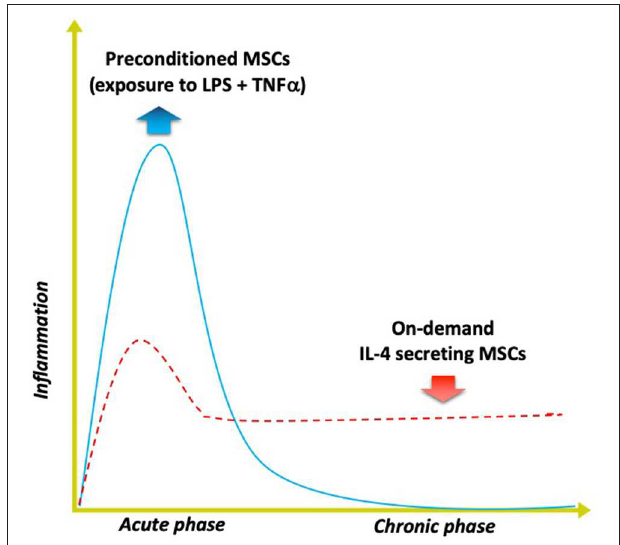
FIGURE 4 | Modulating inflammation with specialized MSCs to enhance bone formation. Optimal bone regeneration is mediated by a transient acute inflammatory reaction (for several days), followed by the resolution of inflammation and the tissue repair phase (blue solid line). Impairment or dysregulation of the acute inflammatory phase may lead to unresolved chronic inflammation and subsequent delayed bone healing (red dashed line). The strategy of using MSCs preconditioned by exposure to both lipopolysaccharide (LPS) plus TNF α ex vivo mimics the acute phase response and enhances the MSCs’ osteogenic and immunomodulating abilities. Alternatively, genetically modified MSCs that first sense NFkB activation then over-express IL-4 secretion (“on demand”) can respond to unresolved chronic inflammation by modulating the local conditions into the desired anti-inflammatory, tissue repair environment for improved bone